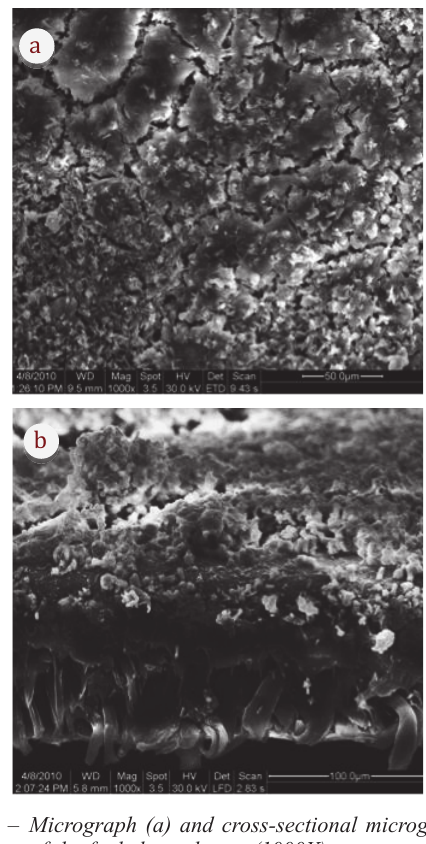
Fig. 4 – Micrograph (a) and cross-sectional micrograph (b) of the fouled membrane (1000X) Table 4 – Values chosen as optimal and limit concentrations for each of the physical-chemical agents used in sequential cleanings Concentration (g m –2